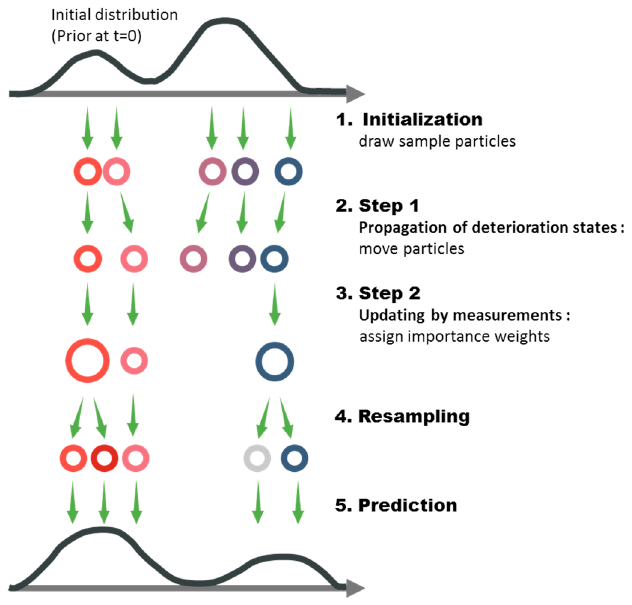
Figure 1. Procedure of particle filter using SIR algorithm.